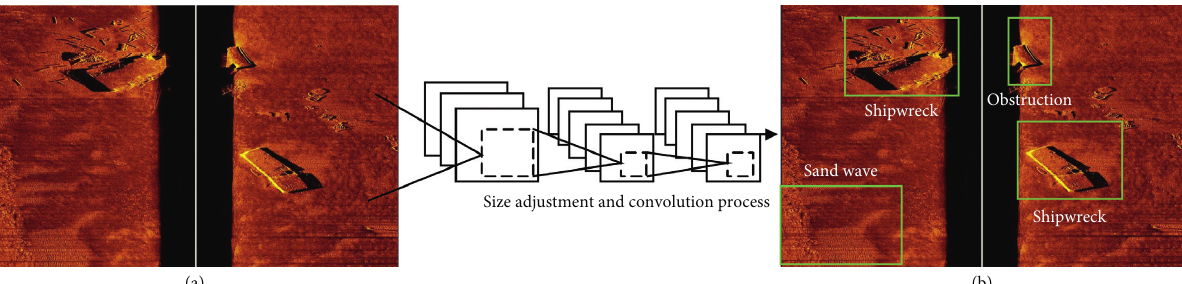
Figure 2: YOLO model flow of marine sediment.